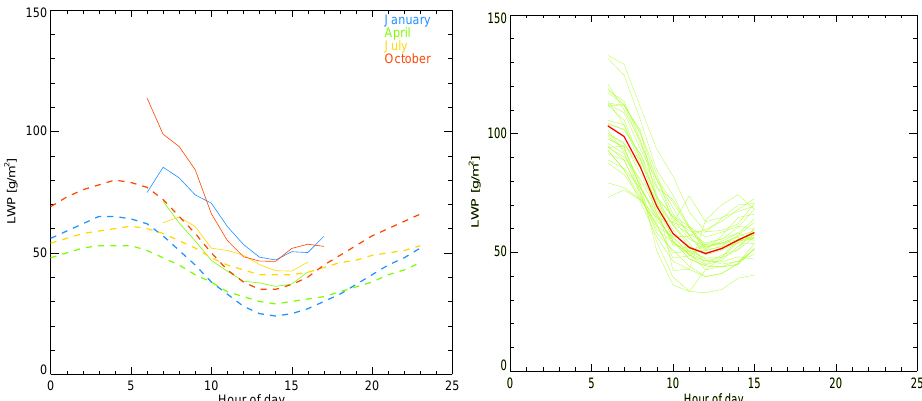
Fig. 9. Left: average diurnal cycle of LWP for 4 months in 2009 from SEVIRI (solid lines) compared to climatological values of 1988–2008 derived from microwave measurements (dashed lines), all cloud types in the low cloud deck off the coast of Namibia and Angola. Right: individual diurnal cycles for October 2009 as seen from SEVIRI, spatially averaged over the low cloud deck region (compare Fig. 1), also cloud-free pixels were included in the average for consistency with the microwave LWP climatology.